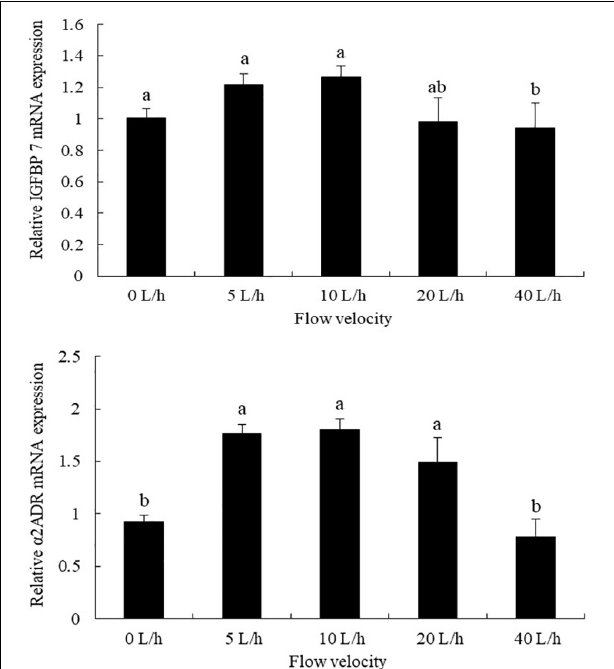
FIGURE 3 | Effects of flow velocity on the relative expression of IGFBP7 (insulin-like growth factor binding protein 7) and α 2ADR ( α 2-Adrenoceptor) in Pacific abalone H. discus hannai larvae. Values are means and standard deviation of four replicates (means ± SD; n = 4). Significant variations were found by one-way analysis of variance, P < 0.05, followed by Tukey test. Different letters denote significant differences between flow